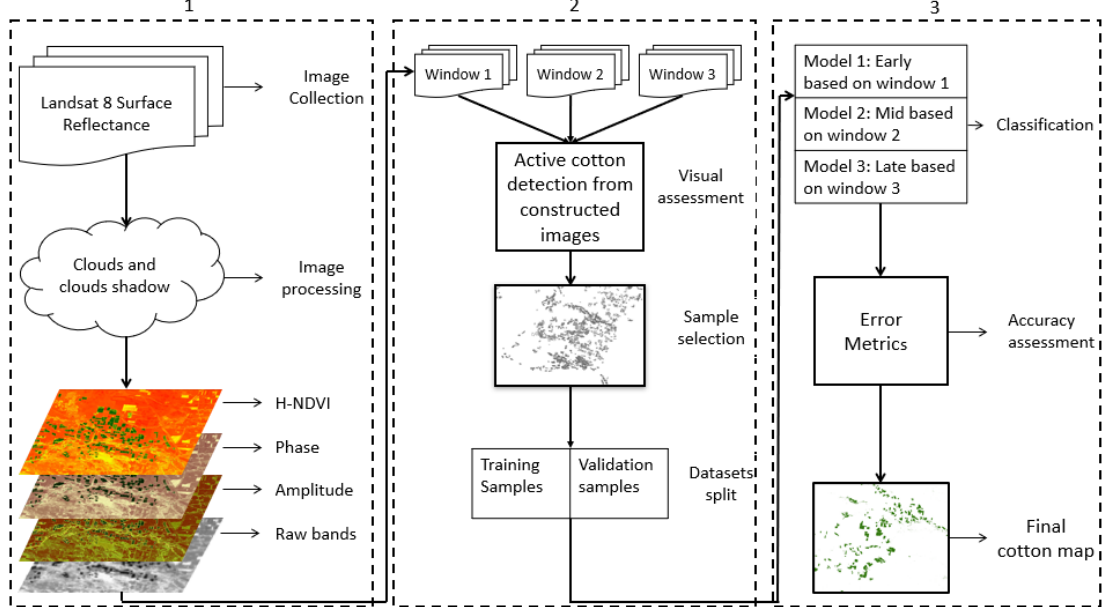
Figure 2. Flowchart of analytical process, the steps of which will be detailed in the following sections. (1) Data acquisition, processing and metric variable extraction. (2) Data preparation for analysis. (3) Data analysis and validation. Window 1 includes images from the 1st of October to the 1st of January for each season. Window 2 includes images from the 1st of October to the 1st of February (this includes images from window 1 and window (2). Window 3 includes images from 1st of October to the 1st of May, including also images from windows 1 and 2.